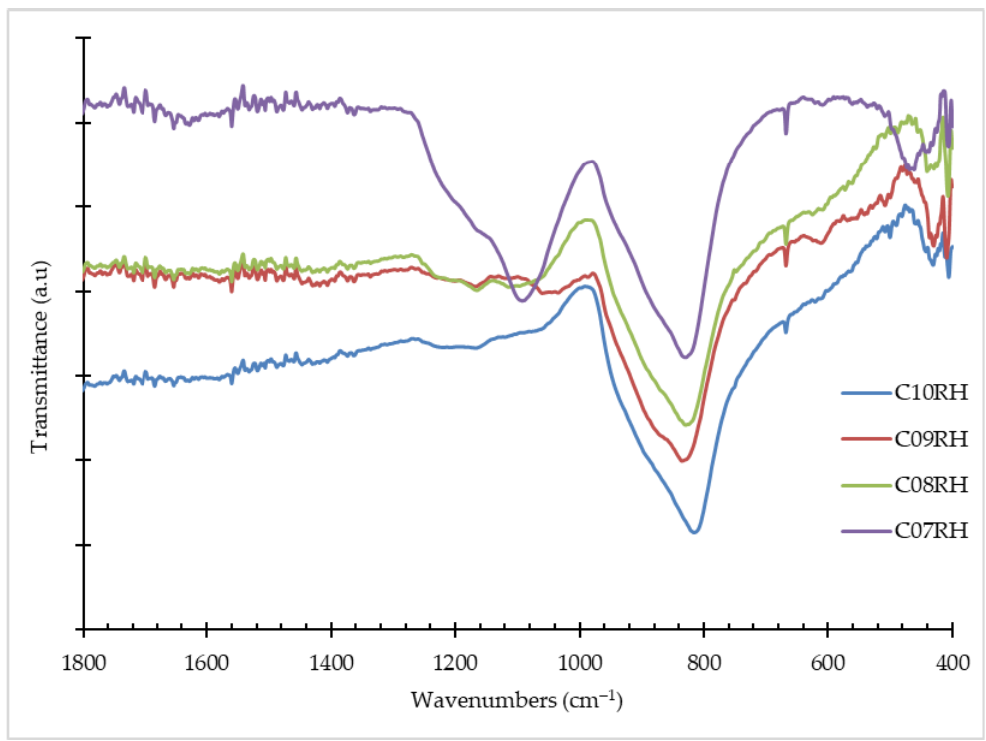
Figure 4. IR spectrum of the reduction product after washing with 1 M HCl solution. Table 3. Comparison of absorption of product from washing with 1 M HCl.